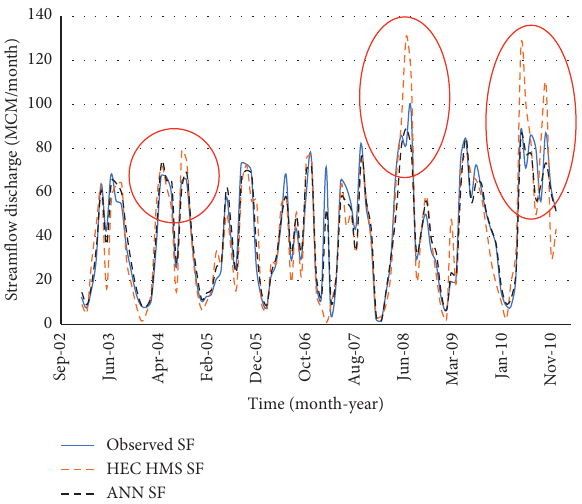
Figure 5: Streamflow comparison of Seethawaka